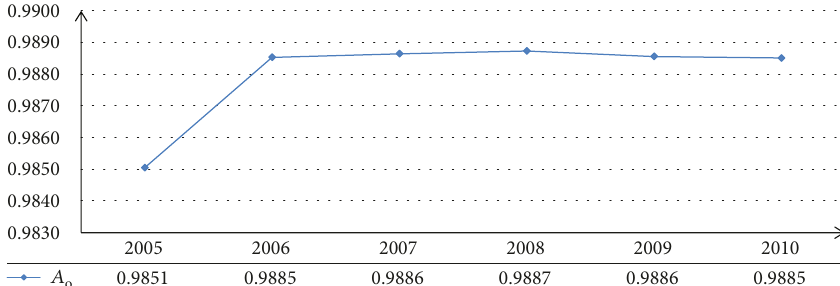
Figure 4: Characteristic form of operational availability function for period